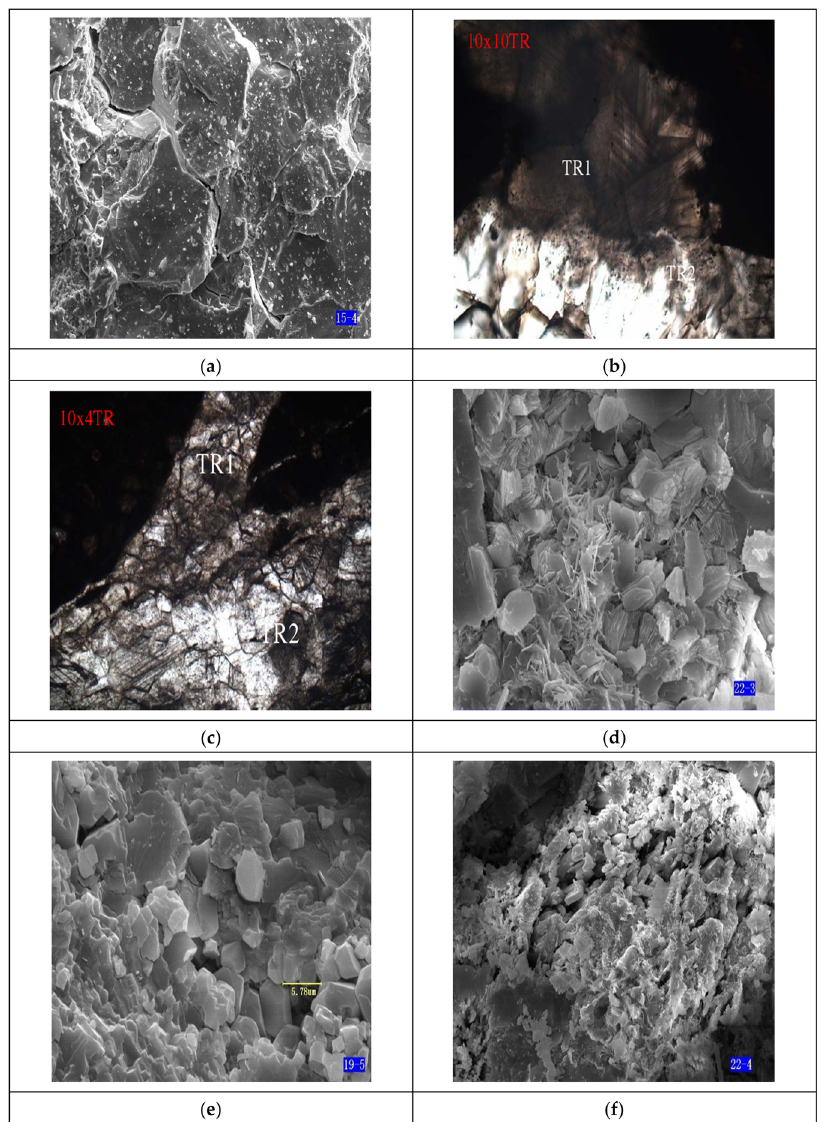
Figure 7: ( a ) The fracturing of samples under observing; ( b ) calcite fi lled with cementation in two mutually cut fractures under transmission light (× 40 ) ; ( c ) two - phase calcite cementation of cracks under transmission light (× 100 ) ; ( d ) clay mineral cementation in clastic rock pores under scanning electron microscope (× 2,000 ) ; ( e ) micropores formed by dissolution in micritic limestone under scanning electron microscope (× 2,500 ) ; and ( f ) secondary porosity formed by dissolution of a few particles under scanning electron microscope (× 800 )